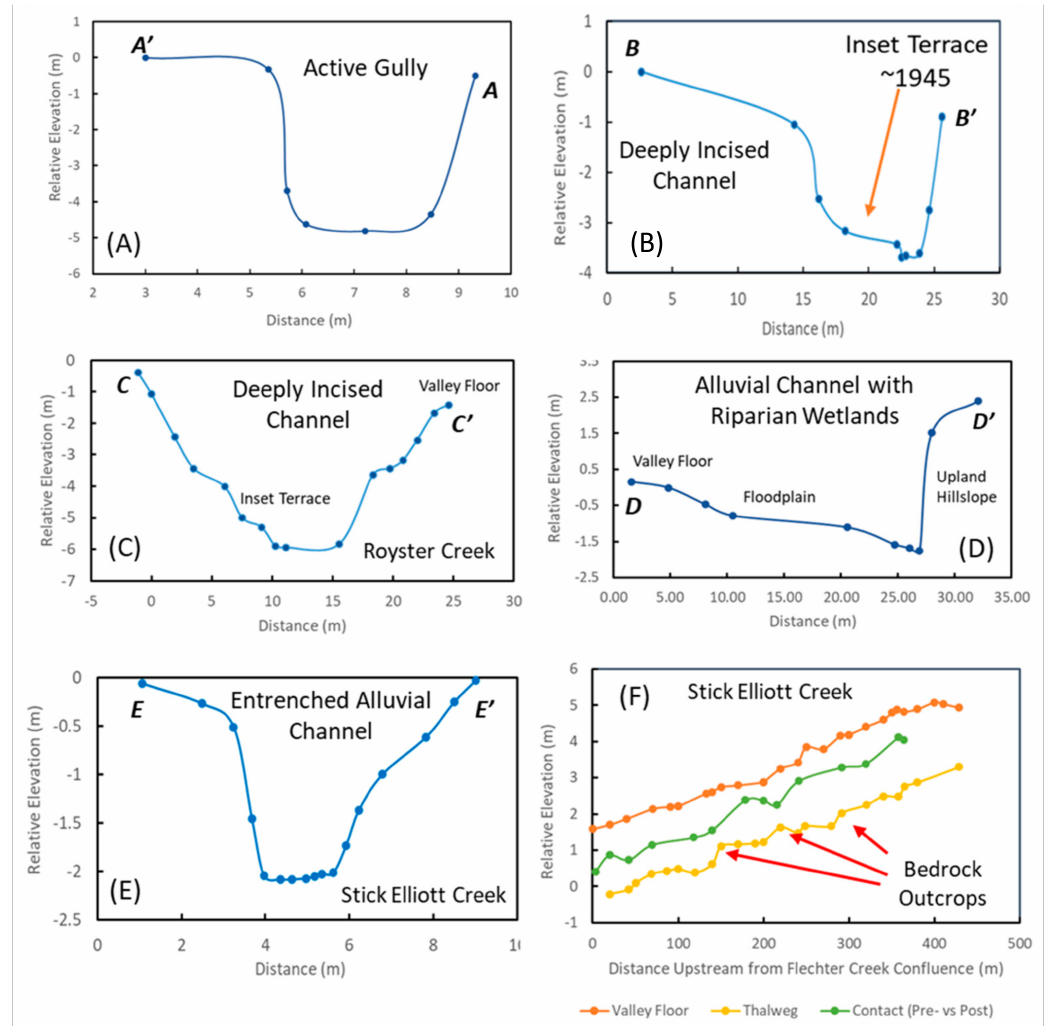
Figure 3. Representative topographic surveys across the major process zones defined within the project area, including ( A ) an active gully at the headwaters of Stick Elliott Creek, ( B , C ) deeply incised channels, ( D ) an alluvial channel with riparian wetlands located along the axial channel of Big Harris Creek, and ( E ) an entrenched alluvial channel along Stick Elliott Creek; ( F ) a longitudinal profile along the lower reach of Stick Elliott Creek shows the relationship between the contemporary channel bed (thalweg)(yellow line), the valley floor (orange line), and the contact between the legacy and precolonial deposits (green line). See Figure 1 for survey